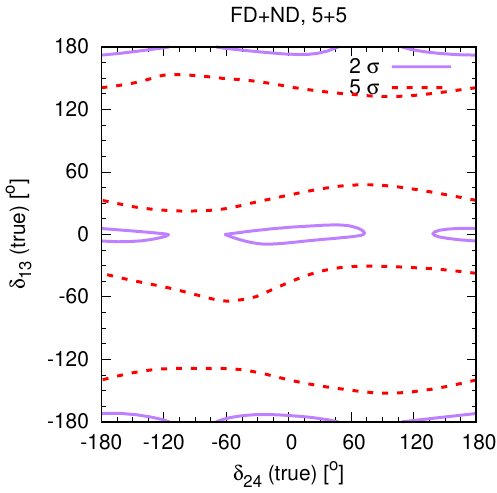
Figure 6 . CP violation sensitivity of ESSnuSB in the (cid:14) 13 (true){ (cid:14) 24 (true) plane. Both (cid:14) 13 and (cid:14) 24 are minimized over 0 (cid:14) and 180 (cid:14) in the test. In addition, (cid:14) 34 is (cid:12)xed to 0 (cid:14) in both true and